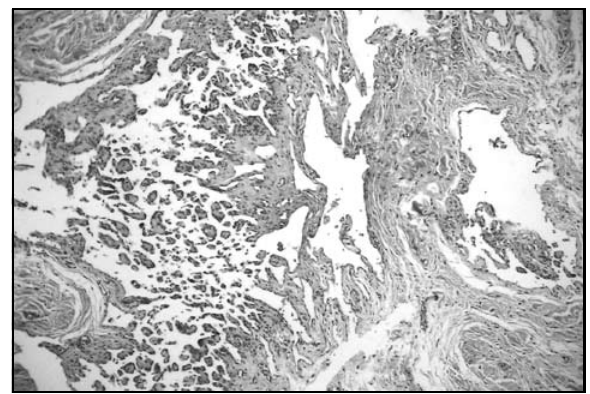
Figura 1 – Evidencia-se, em dois vasos sangüíneos, a proliferação intraluminal de células endoteliais arranjadas de forma papilar (HE